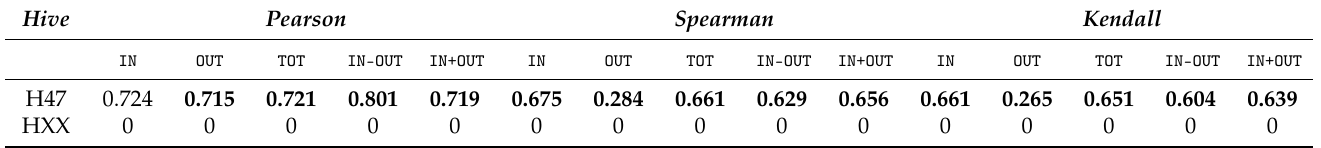
Table 2. Pearson, Spearman, and Kendall p -values rounded to 3 decimal places for hives H17, H19, H41, H43, H47, and H53 and five traffic types: IN (incoming), OUT (outgoing), TOT (total), IN-OUT (difference of IN and OUT), and IN+OUT (sum of IN and OUT), where TOT = IN+OUT+LAT and LAT is lateral traffic; IN, OUT, LAT, and TOT are non-negative integers; p -values for H47 are bolded, because it was the only hive for which H ρ ,0 was not rejected at p ≤ 0.05 for any coefficient and any traffic type; HXX refers to H17, H19, H41, H43, and H53, because their p -values were identically 0.